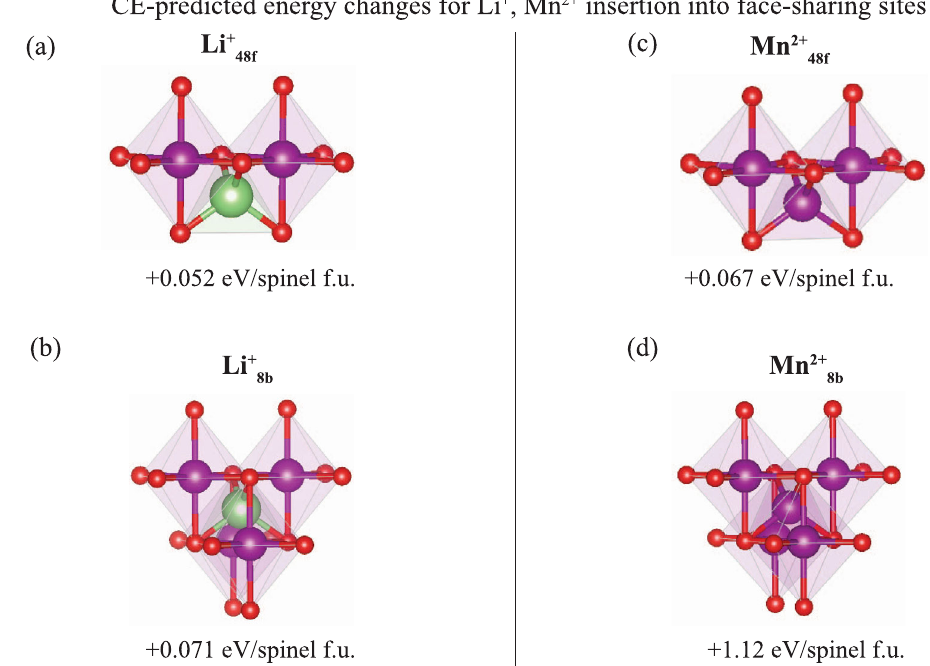
Fig. 4 Examples of high-energy cation con fi gurations predicted by the CE per spinel formula unit (f.u.), LiMn 2 O 4 , where the scenarios are Li + or Mn 2 + insertions onto vacant sites in spinel (48f or 8b). The defect energies are calculated as either E final (cid:2) E initial (cid:2) μ Li þ and E final (cid:2) E initial (cid:2) μ Mn 2 þ